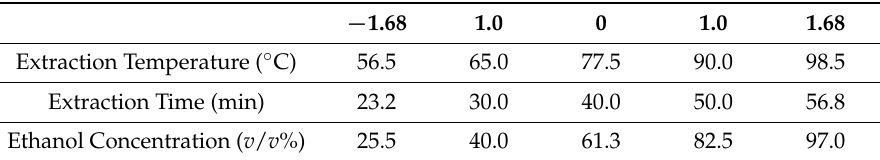
Table 5. The factors and levels of central composite